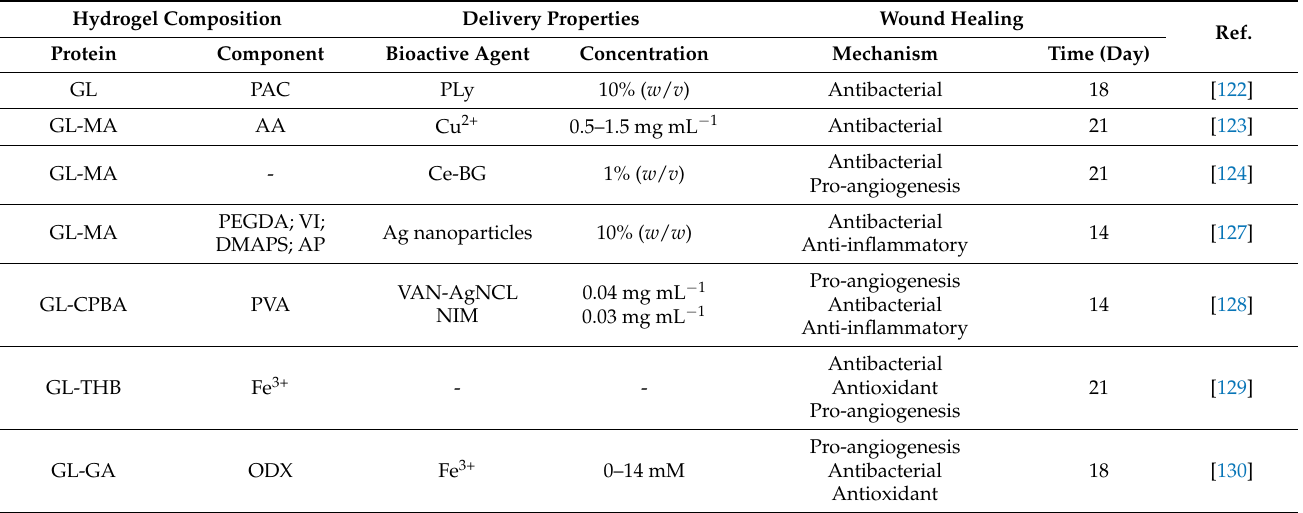
Table 8. Antibacterial gelatin-based gelatin hydrogels employed in the diabetic wound healing. Hydrogel Composition Delivery